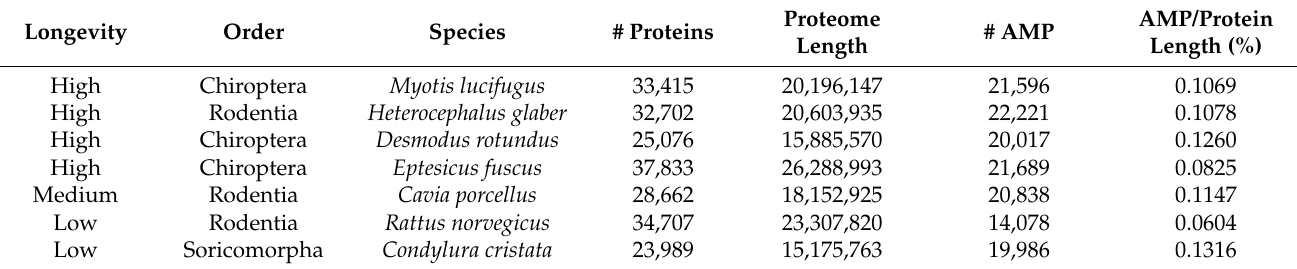
Table 1. Animal proteomes with embedded